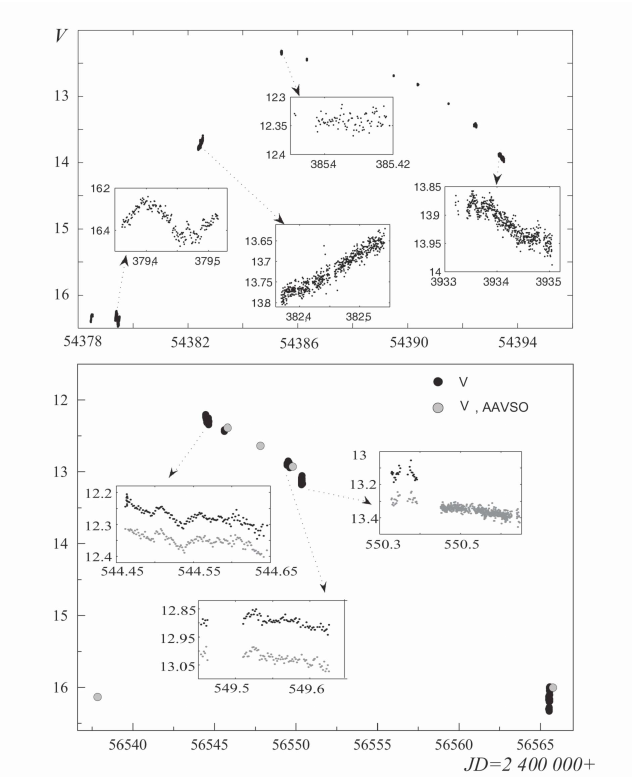
Figure 2: The outburst LCs in 2007 (top) and 2013 (bottom) in V (black points and circles) and B (grey points). The AAVSO V data are marked by grey cir- cles.